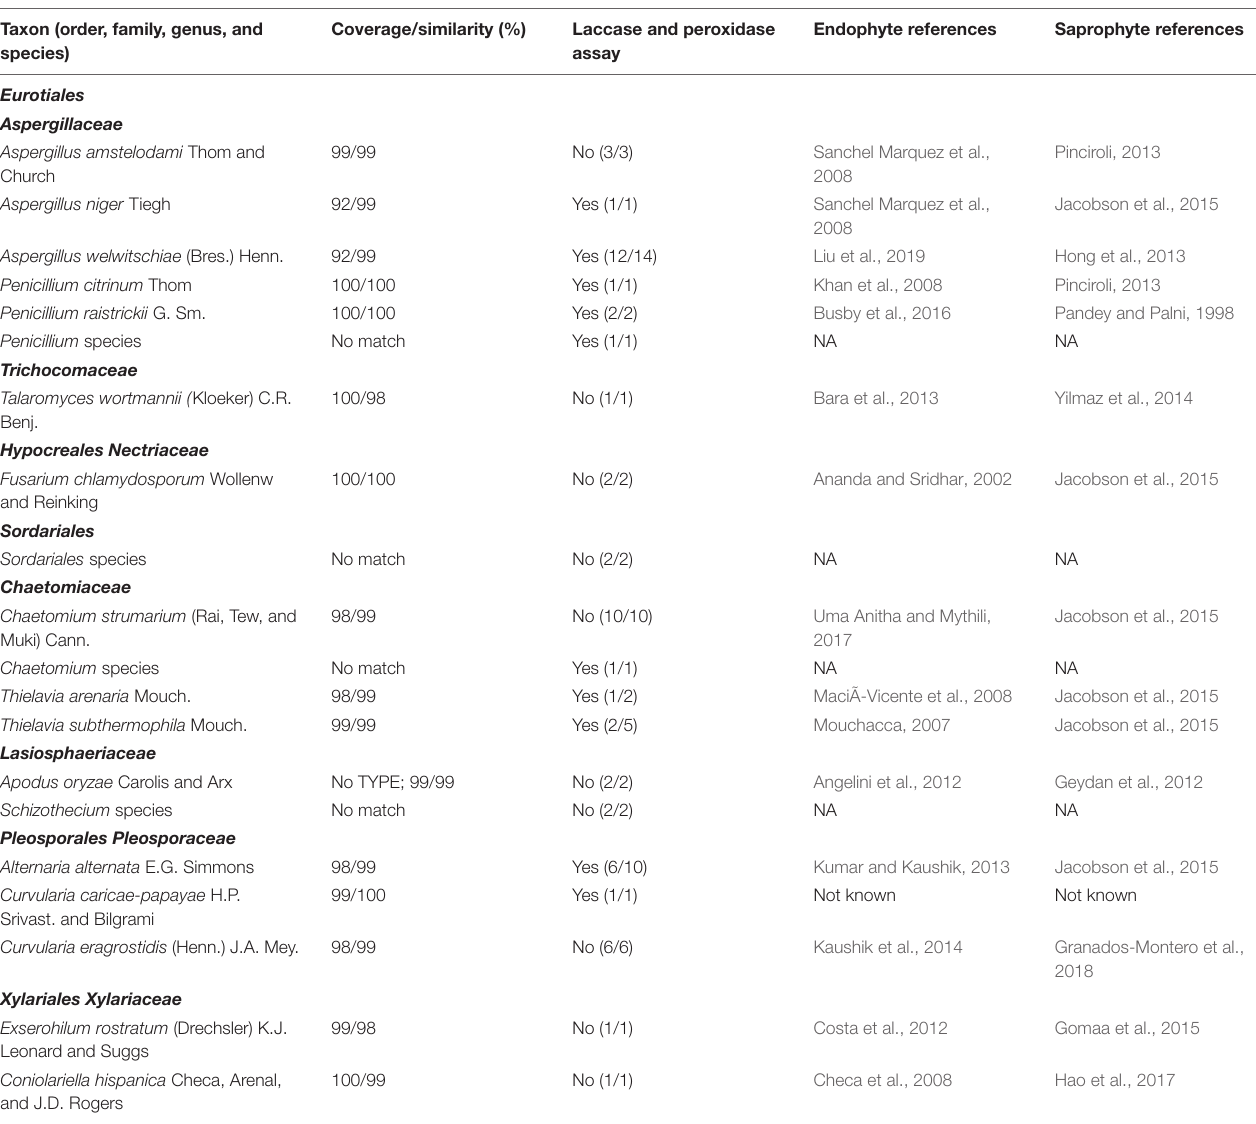
TABLE 1 | Endophytic taxa isolated from Stipagrostis sabulicola . Taxon (order, family, genus, and